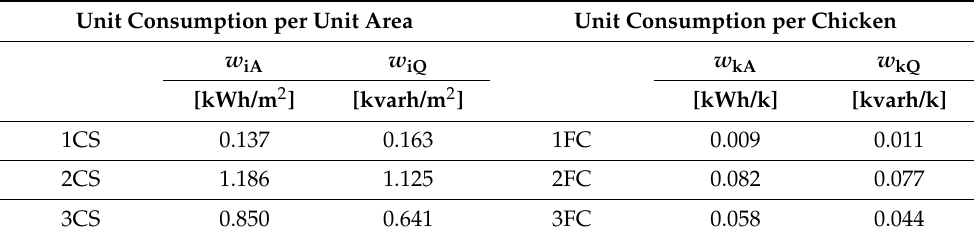
Table 6. Electricity consumption in each stage of the cycle per unit area and per chicken.